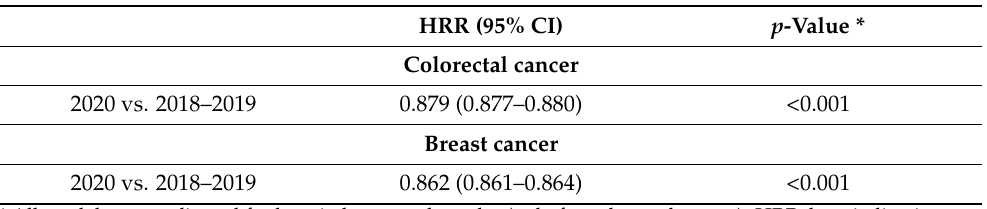
Table 2. Hospitalization rate ratios of colorectal and breast cancer in last ten months of 2020 compared with the two-year period 2018–2019.